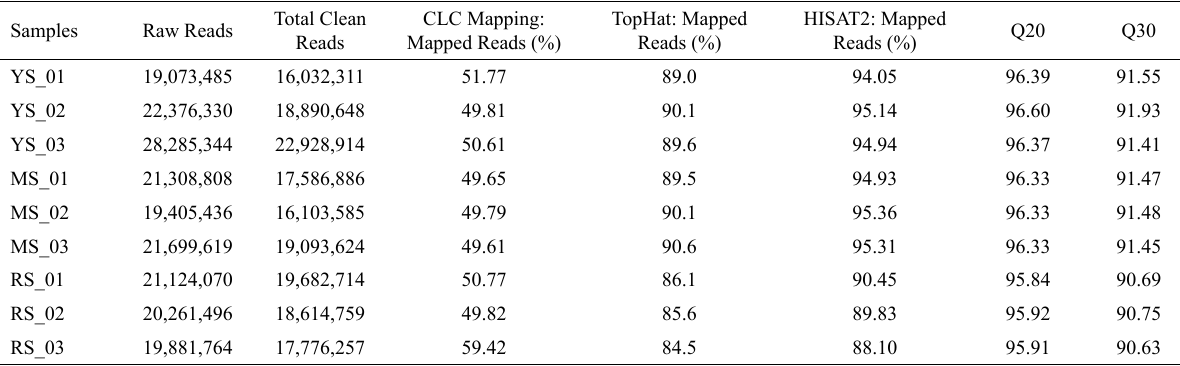
YS, young stage; MS, mature stage; RS, ripening stage; DPA, days post